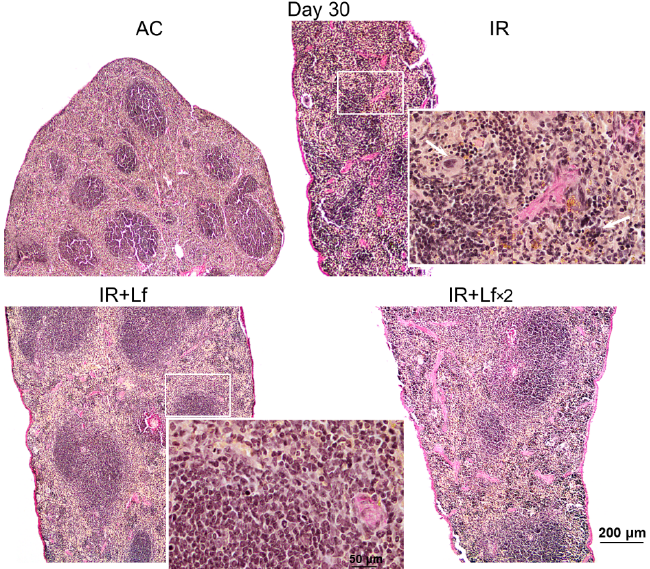
Figure 12. Protective effect of Lf on the structural organization of the spleen in the irradiated mice. Representative photomicrographs of spleen sections on day 30 after 7.5 Gy whole-body gamma irradiation. Groups: AC (sham-irradiated), IR (irradiated), IR+Lf (Lf was administered immediately after irradiation; i.p.; 4 mg/mouse), IR+Lf×2 (Lf was administered twice: immediately after irradiation and 24 h after it). Megakaryocytes (arrows). van Gieson staining. Scale bars = 200 μ m and 50 μ m.